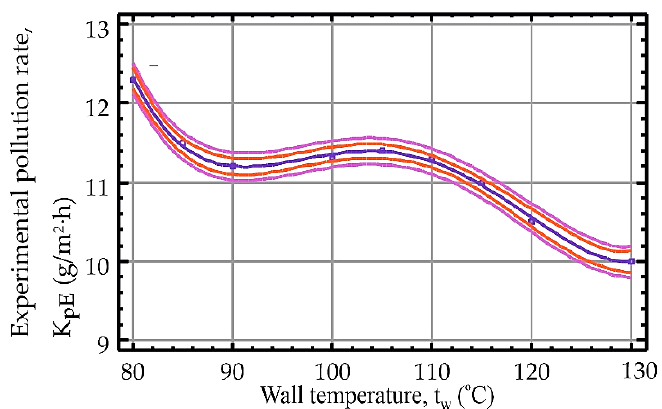
Figure 9. Experimental dependences of pollution rate K pE from wall temperature t w with confidence and prediction curves during the WFE combustion.